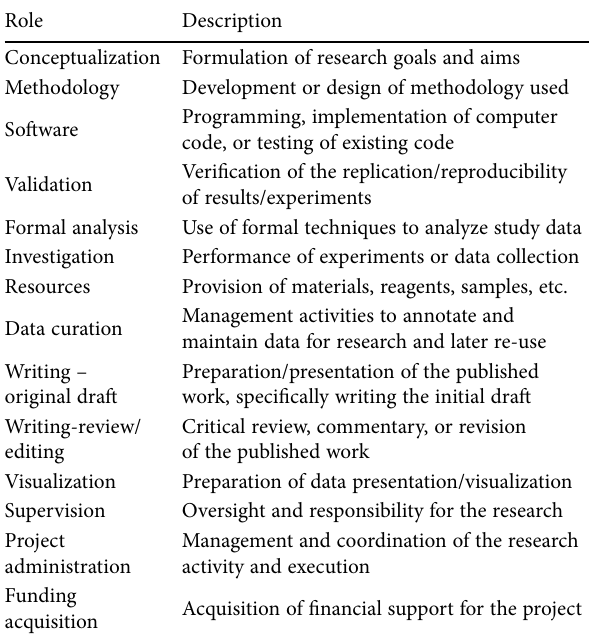
Table 1. Contributor Roles Taxonomy